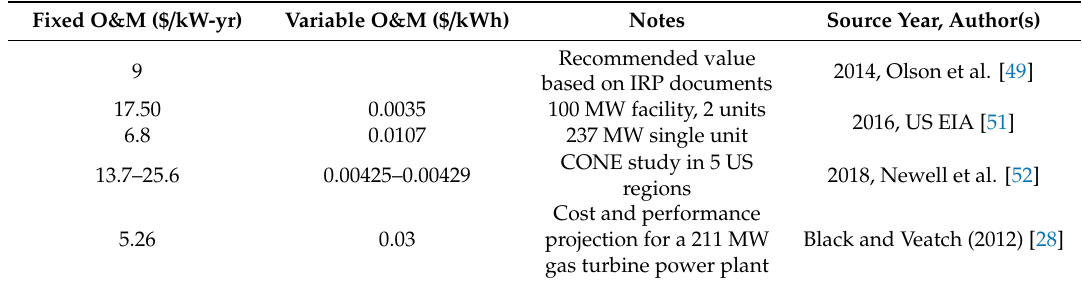
Table 10. Fixed and variable O&M costs—CT